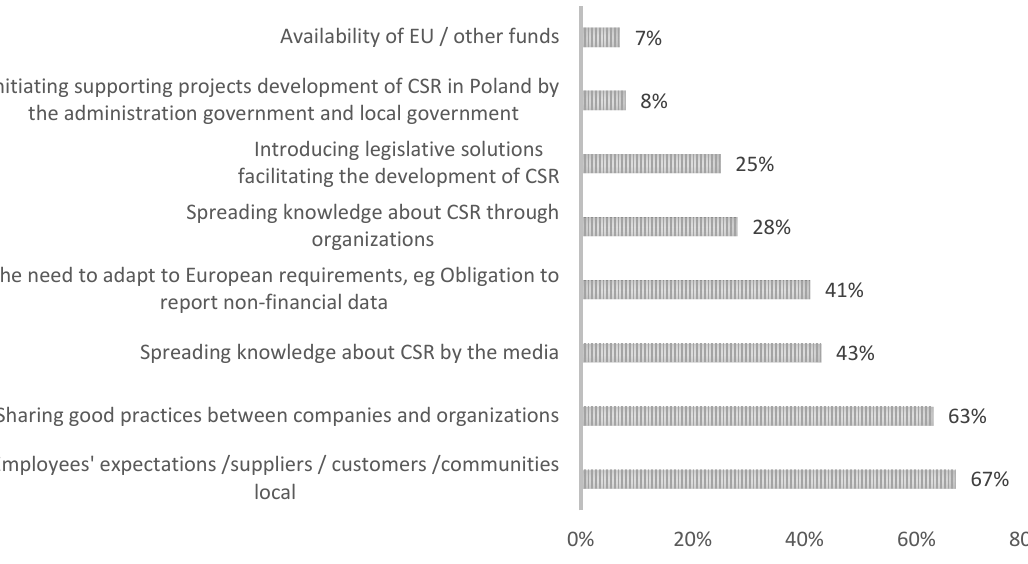
Figure 1. Reasons for the involvement of enterprises in Poland in CSR activities. Sources: based on [45].